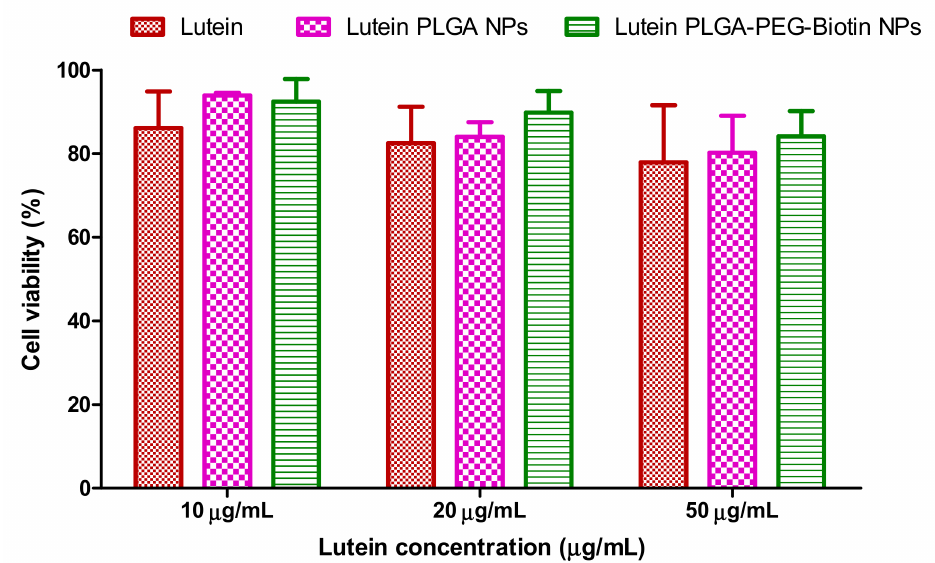
Figure 9. Cell viability (%) of ARPE-19 cells when treated with increasing concentrations of lutein and lutein-loaded polymeric